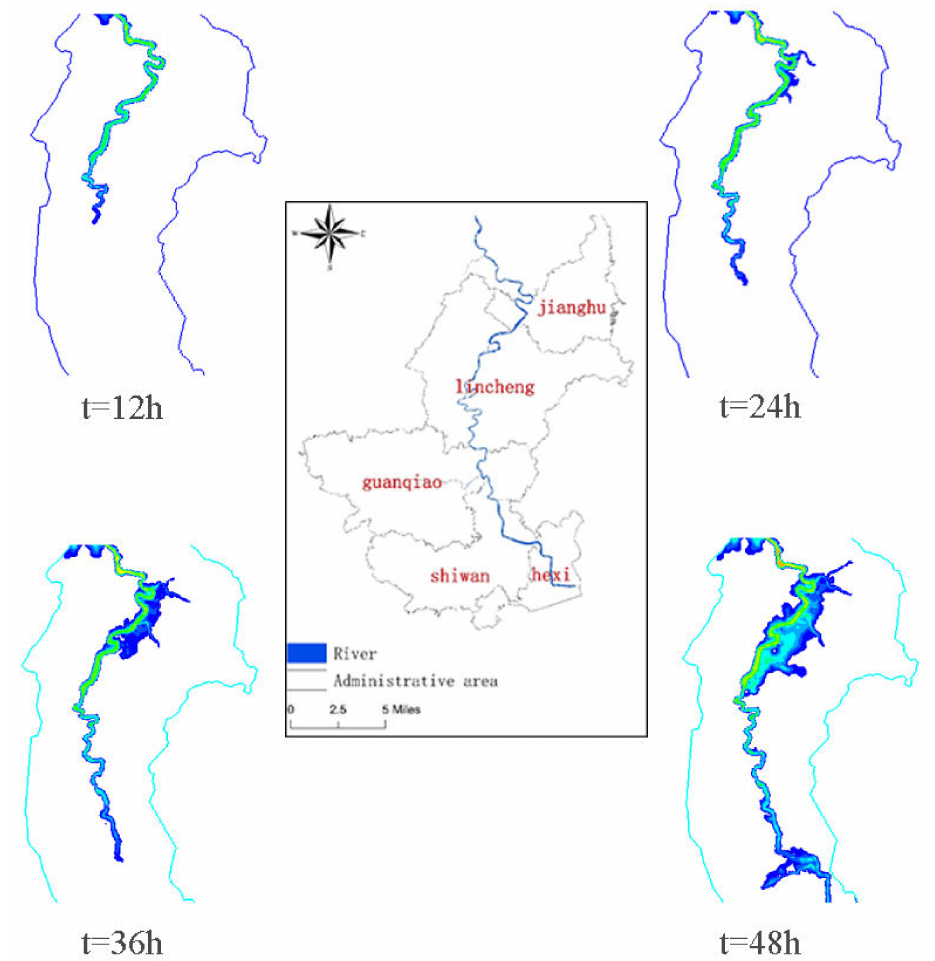
Figure 7. Simulated flood depth and extent of 1D / 2D model at 12 h, 24 h, 36 h, and 48 h after the river dike